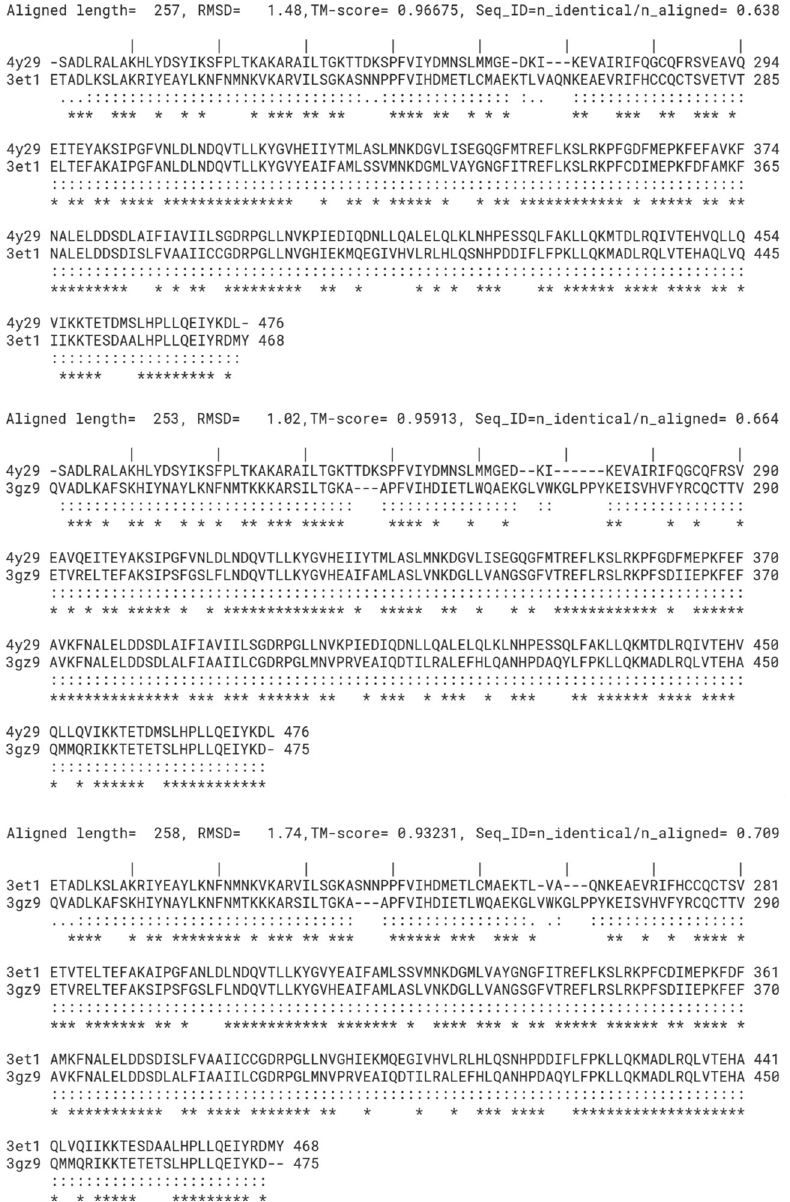
Figure 4: Structure-based sequence alignment of the three PPAR variants. Top to bottom: PPAR γ (PDBID 4y29) versus PPAR α (PDBID 3et1), PPAR γ (PDBID 4y29) versus PPAR β / δ (PDBID 3gz9), and PPAR α (PDBID 3et1) versus PPAR β / δ (PDBID 3gz9). For each pair of variants, aligned length, RMSD, TM-score, and sequence identity were reported using the TM-align algorithm. For each aligned residue pair, “ : ” denotes distance < 5:0 Å, “ . ” denotes farther aligned residues, and “ * ” denotes identical